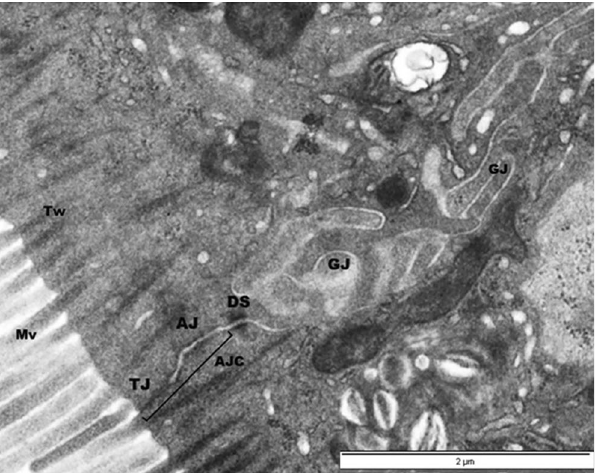
Figure 1. Transmission electron micrograph of a normal apical junctional complex (AJC), the structure between two adjacent enterocytes from the ileal epithelium region of a 21 d old chick. The AJC